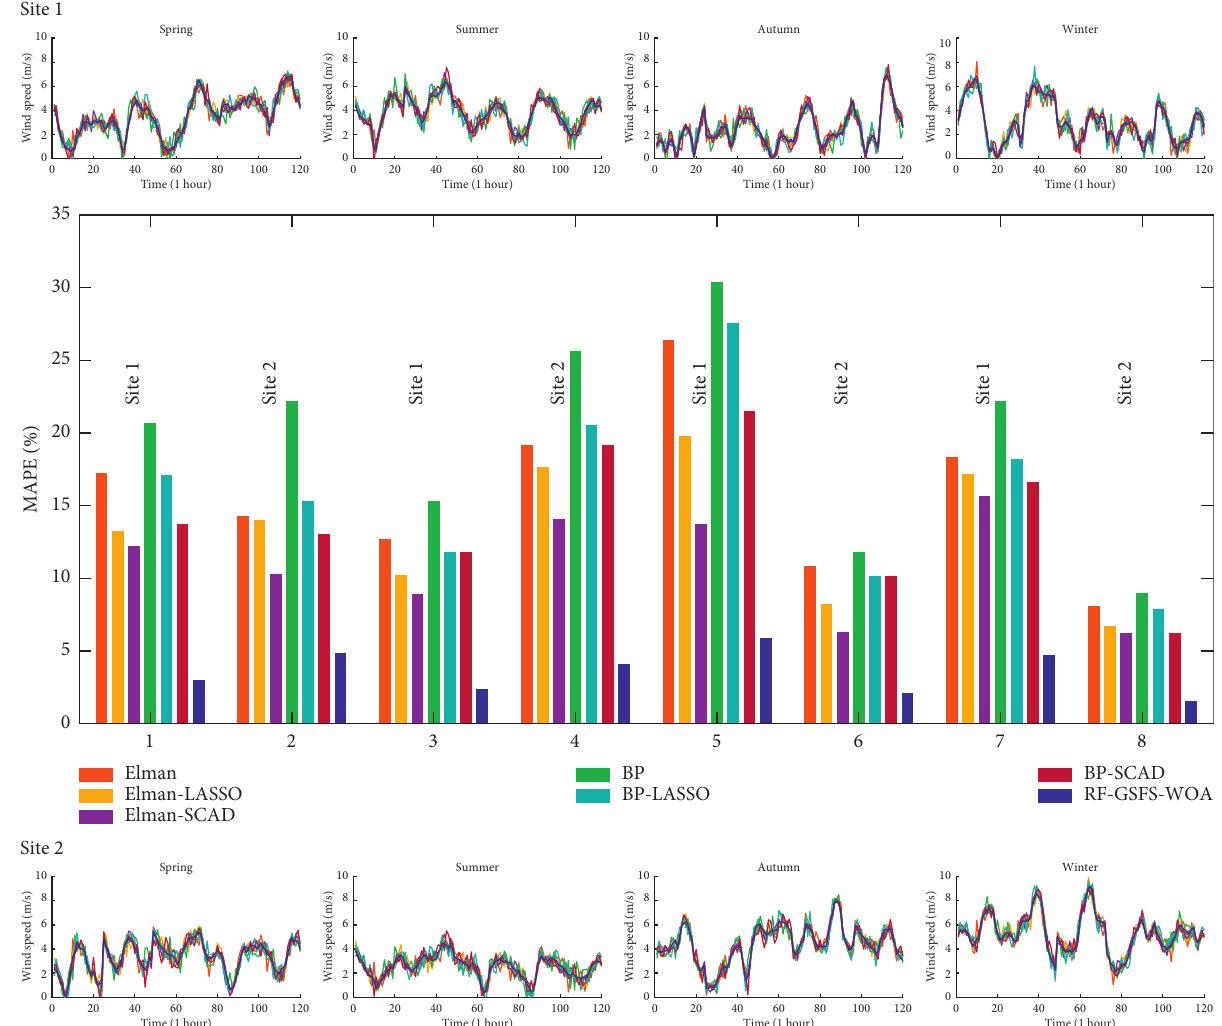
Figure 5: The forecasting results of seven models at Site 1 and Site